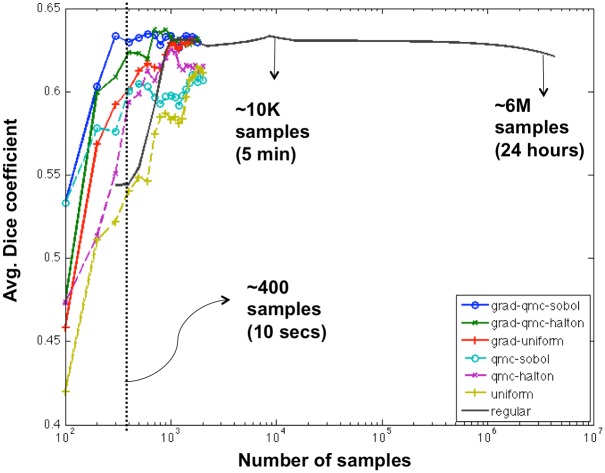
Quantitative evaluation of the different sampling strategies in terms of average Dice coefficient (y-axis) versus the number of samples (x-axis) used.All strategies were trained with D3 and evaluated with D5.